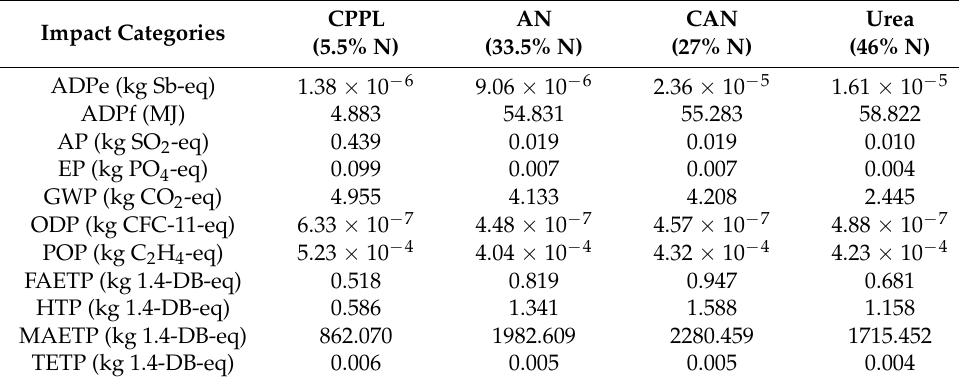
Table 8. Impact assessment of the production of 1 kg of nitrogen